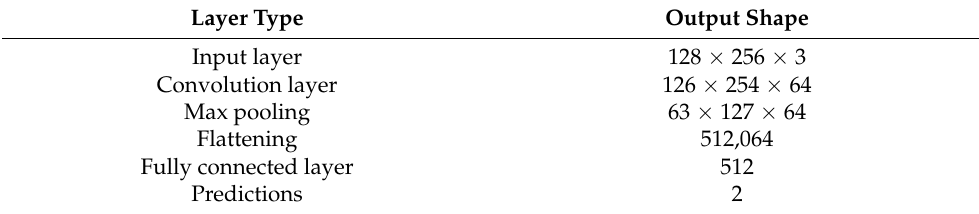
Table 5. Specification of the model architecture.